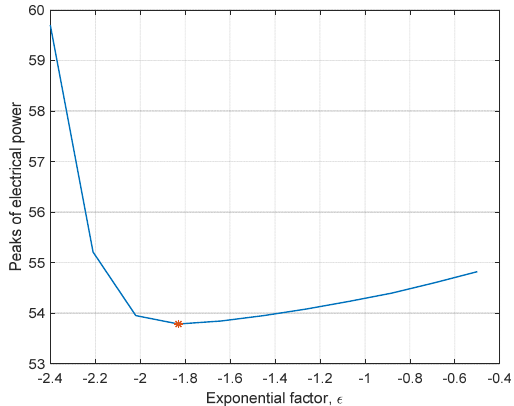
Fig.4 Brute-force method for six trial trajectories at nominal